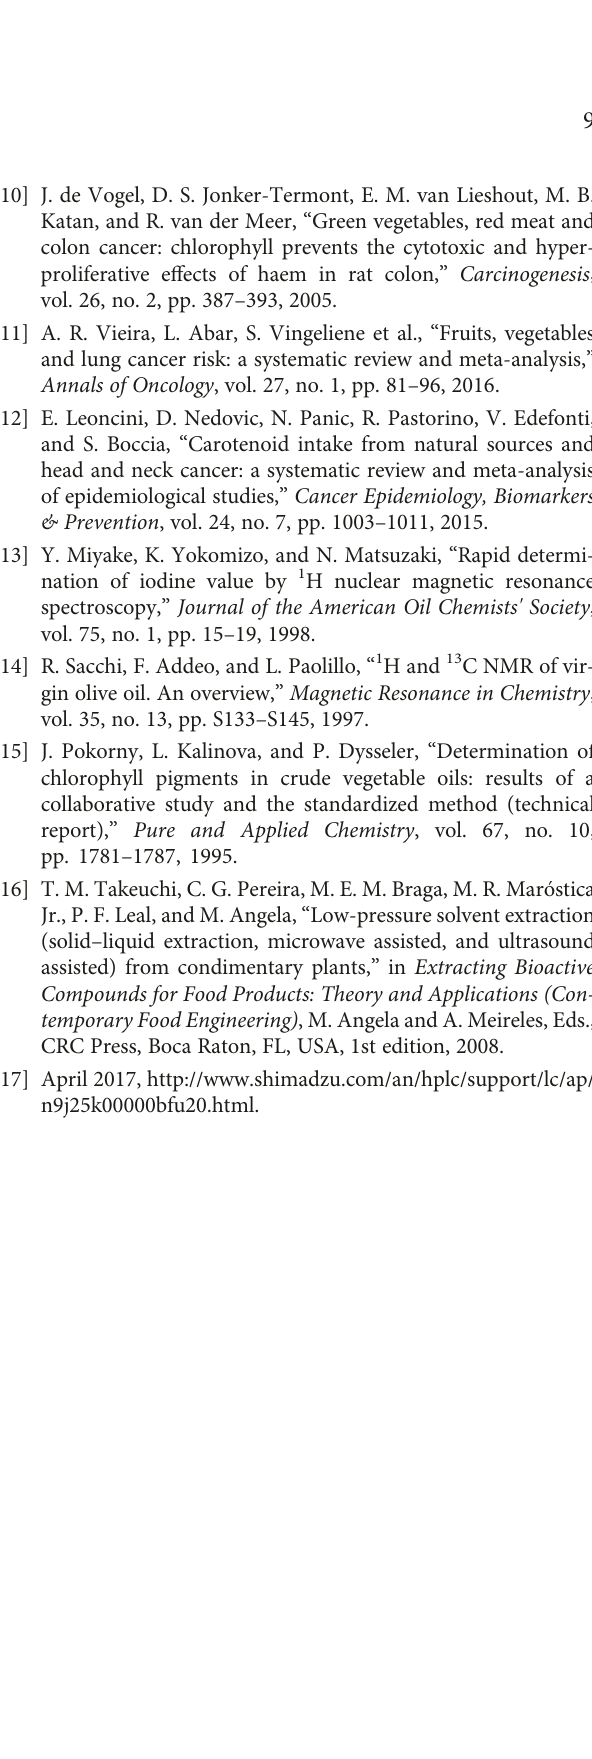
Figure S1: summer savory conventional maceration, results of UV-Vis measurements. Figure S2: summer savory ultra- sound maceration, results of UV-Vis measurements. For comparison with conventional maceration, see Figure